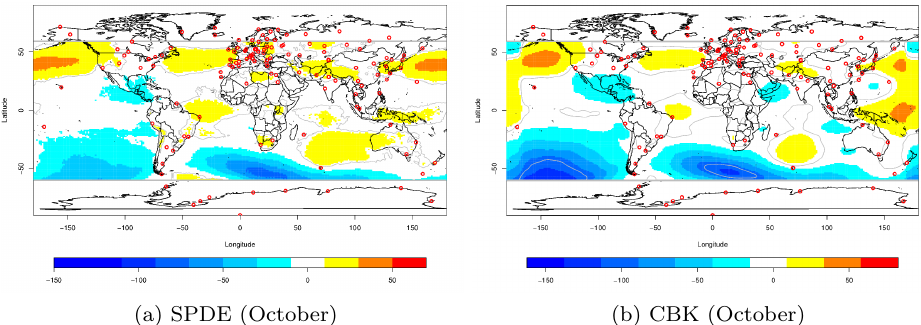
Figure 5. Total ozone (DU) difference mapping of SPDE and covariance-based kriging (CBK) estimated mean with respect to satellite data from October 2000. Estimation in October shows worse prediction than other months; hence it used different scale from Fig.